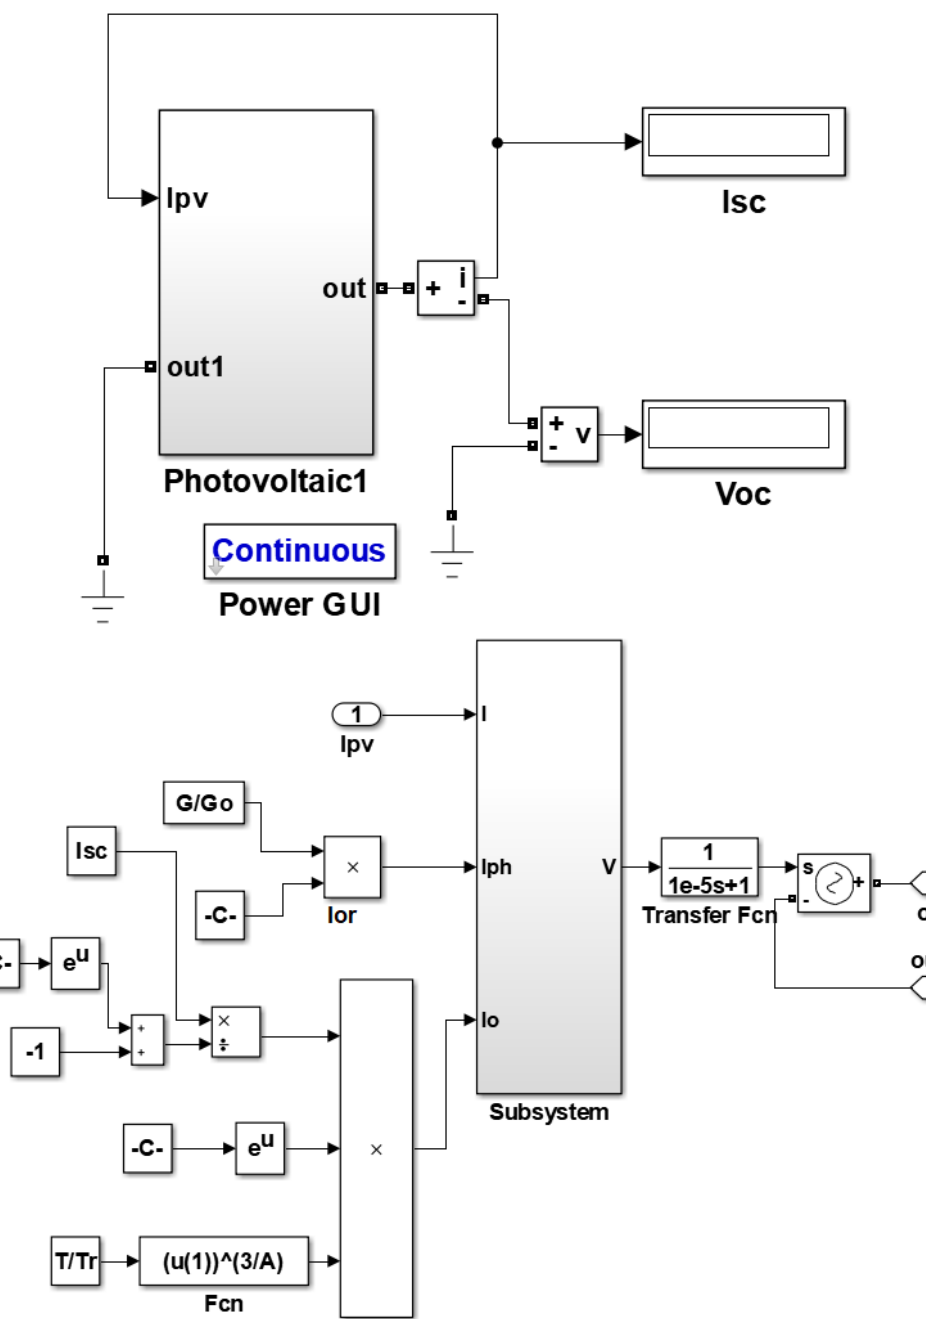
Figure 7. MATLAB Simulink model of 50 watt PV panel.